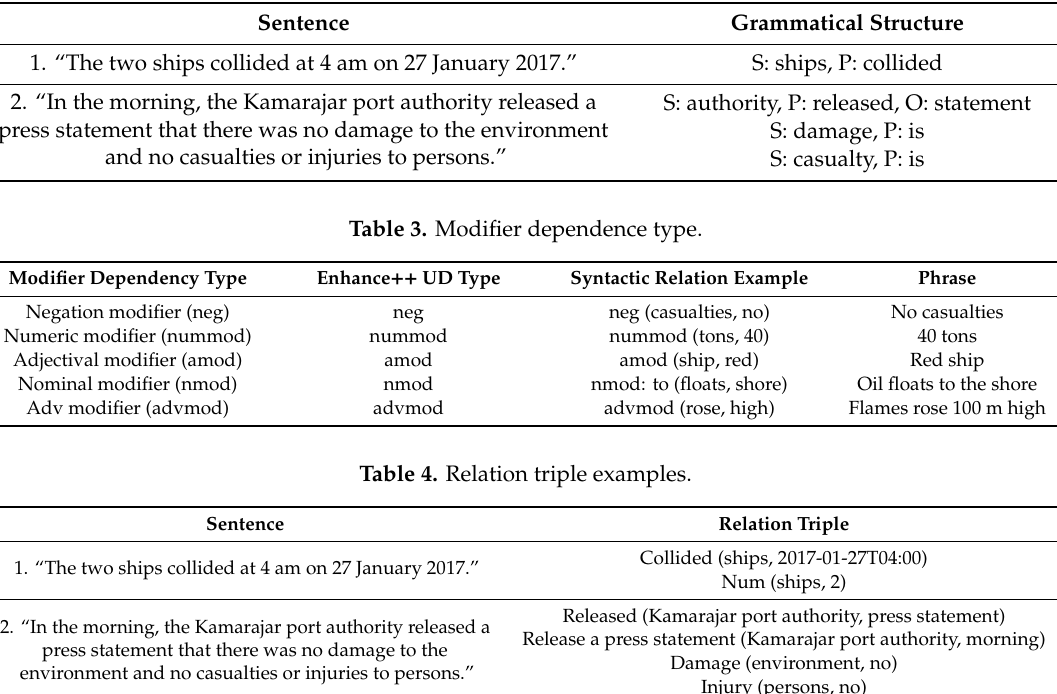
Table 2. Dependency annotation examples.